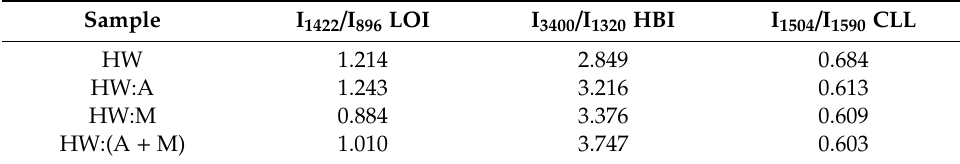
Table 2. FTIR peak ratios of HW particles without and with di ff erent